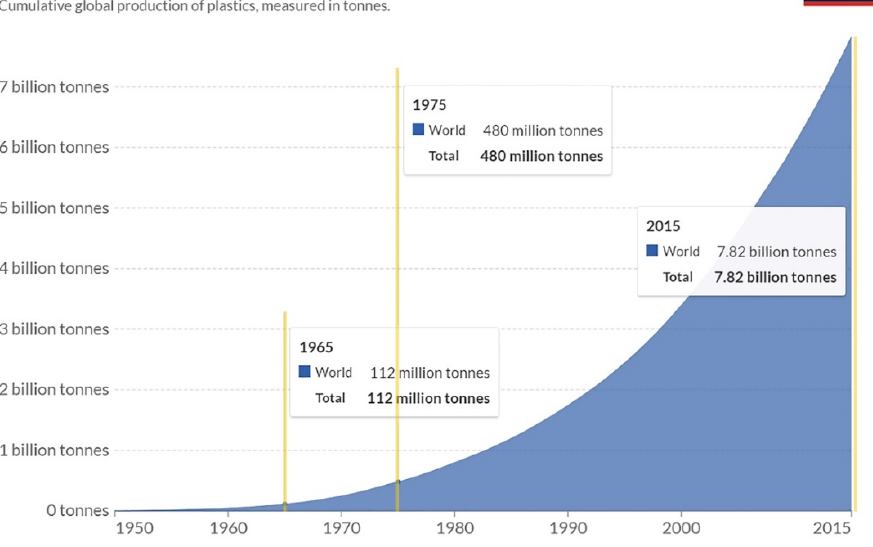
Figure 5. Global accumulated plastics production. Adapted from Ref.